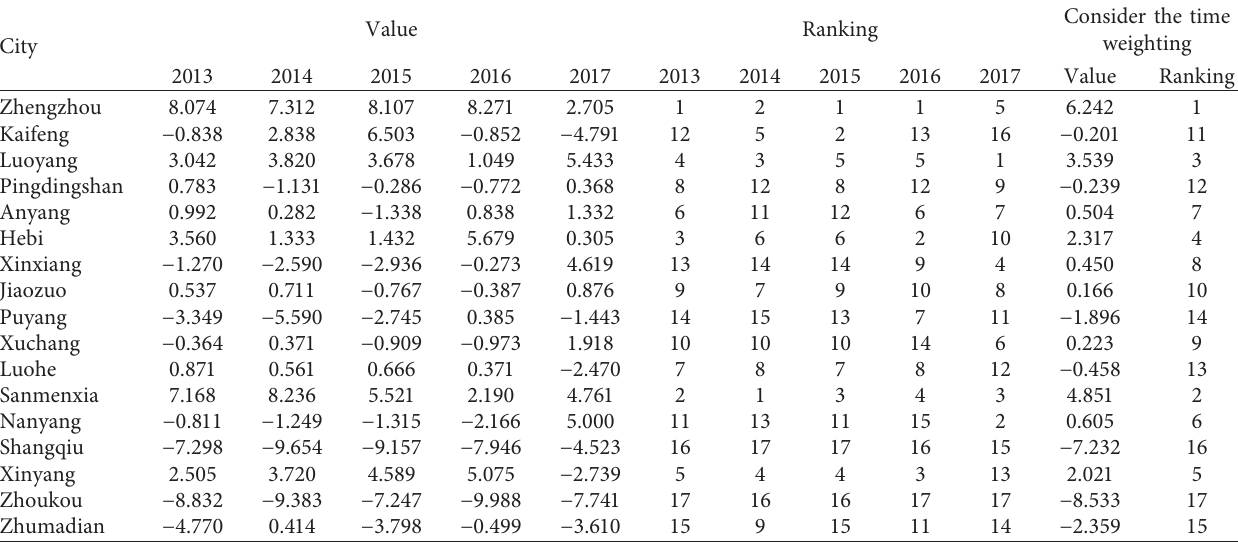
Table 5: The sustainability evaluation value and ranking of each city in the social dimension.